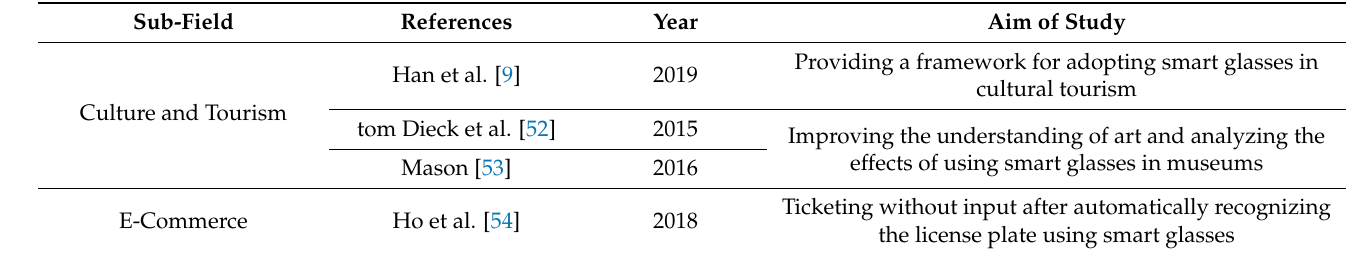
Table 4. Summary of smart glass applications in the service field.